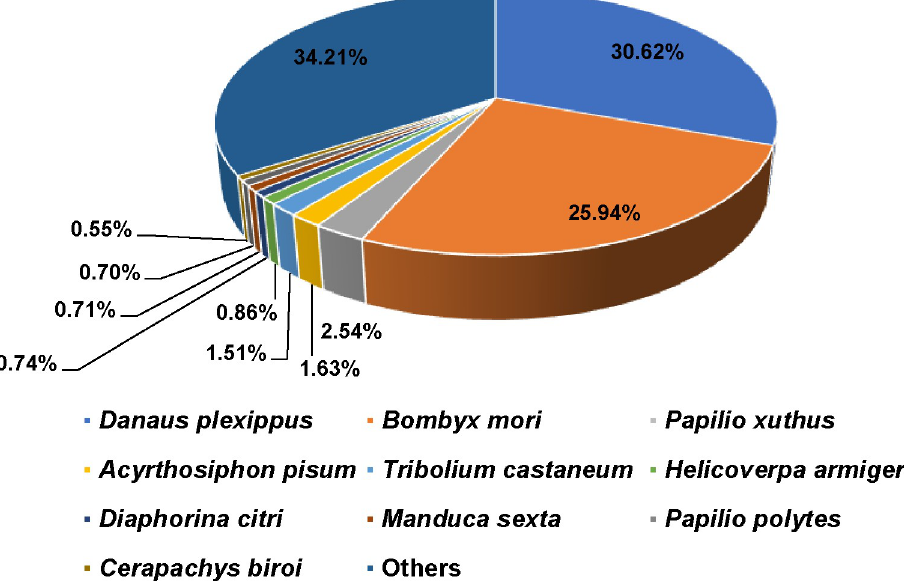
Fig 1. Species distribution based on homology searches of S . insularis unigenes against the NCBI Nr protein database.